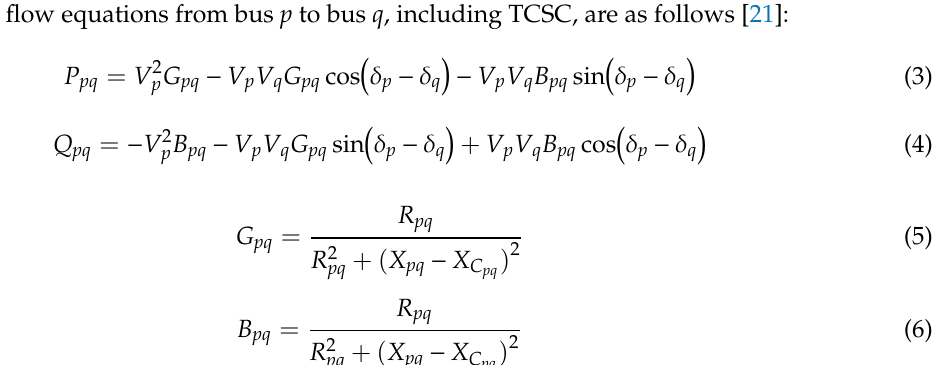
Figure 1. Model of TCSC connected between p th bus and q th bus.